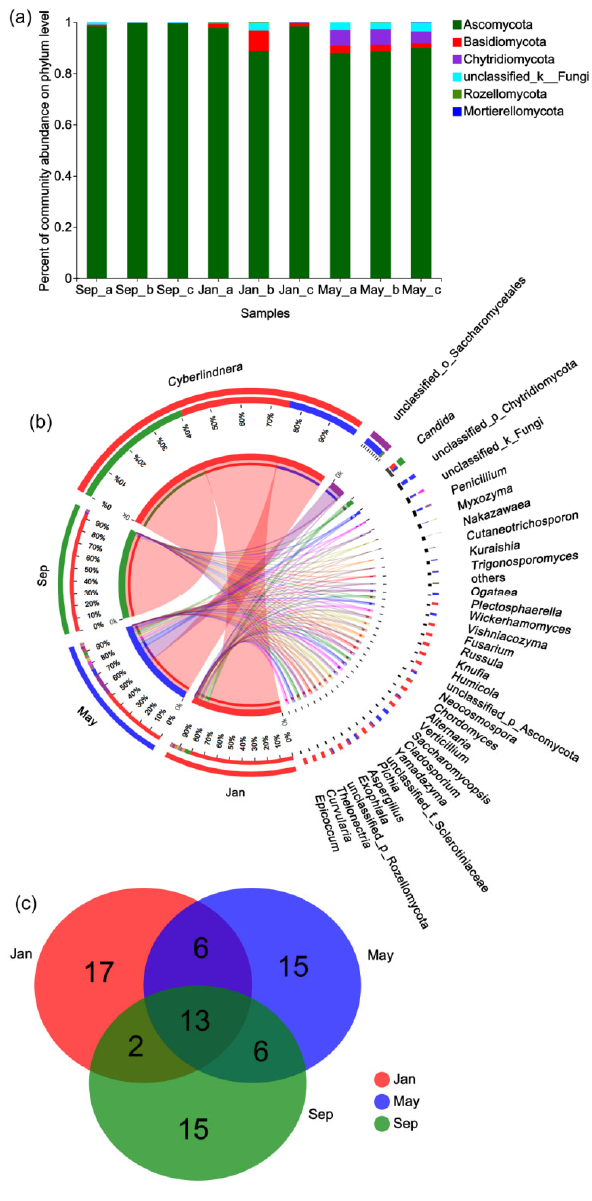
Figure 3. The diversity of the larval RTB gut microbiome across different seasons showing data for the fungal communities. ( a ) The gut microbiota composition at the phylum level. ( b ) The gut microbiota composition at the genus level. ( c ) The numbers of common and unique genera found in the larvae collected in different seasons.